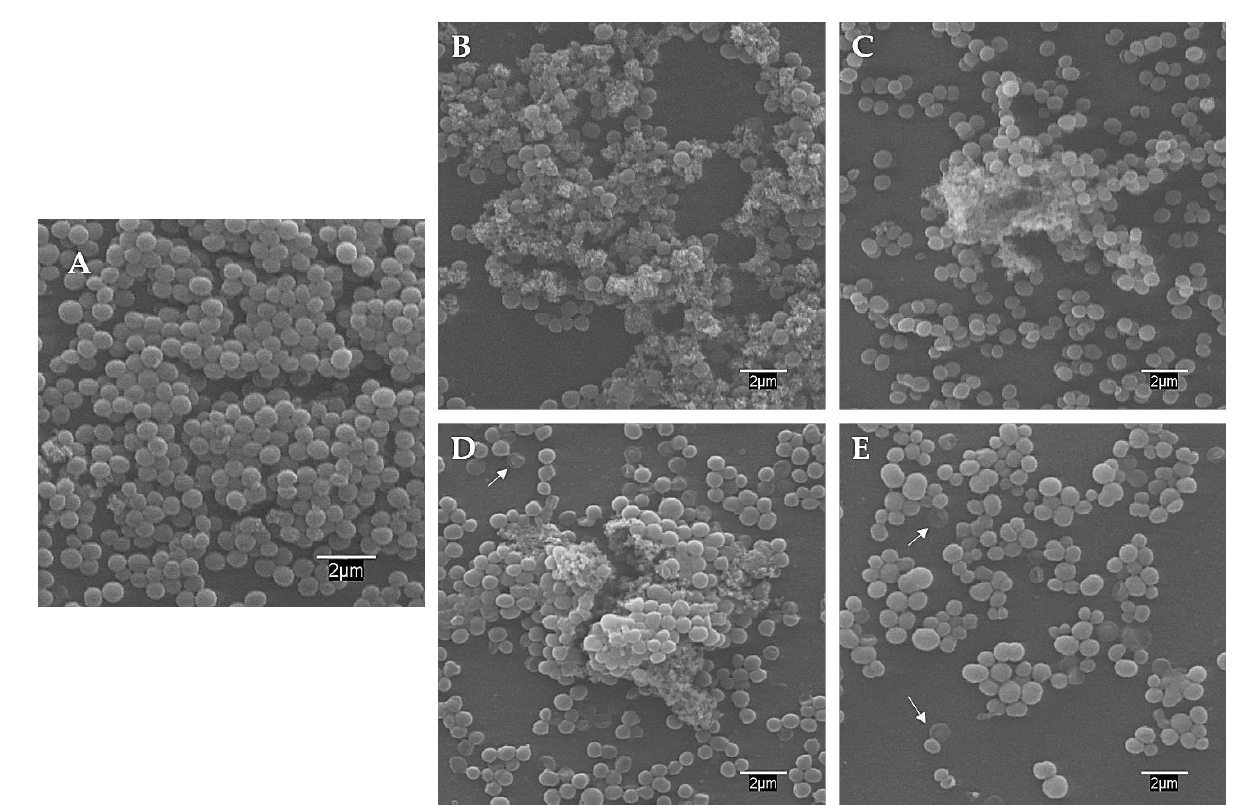
Figure 2. SEM images of post-treatment alteration produced on S. aureus biofilms. ( A ) Untreated control; ( B ) 64 mg/L dendron; ( C ) 64 mg/L DPC; ( D ) 64 mg/L dendron- 8 mg/L LEV (Dendron-LEV); ( E ) 64 mg/L DPC- 8 mg/L LEV (DPC-LEV). White arrows: collapsed cells.